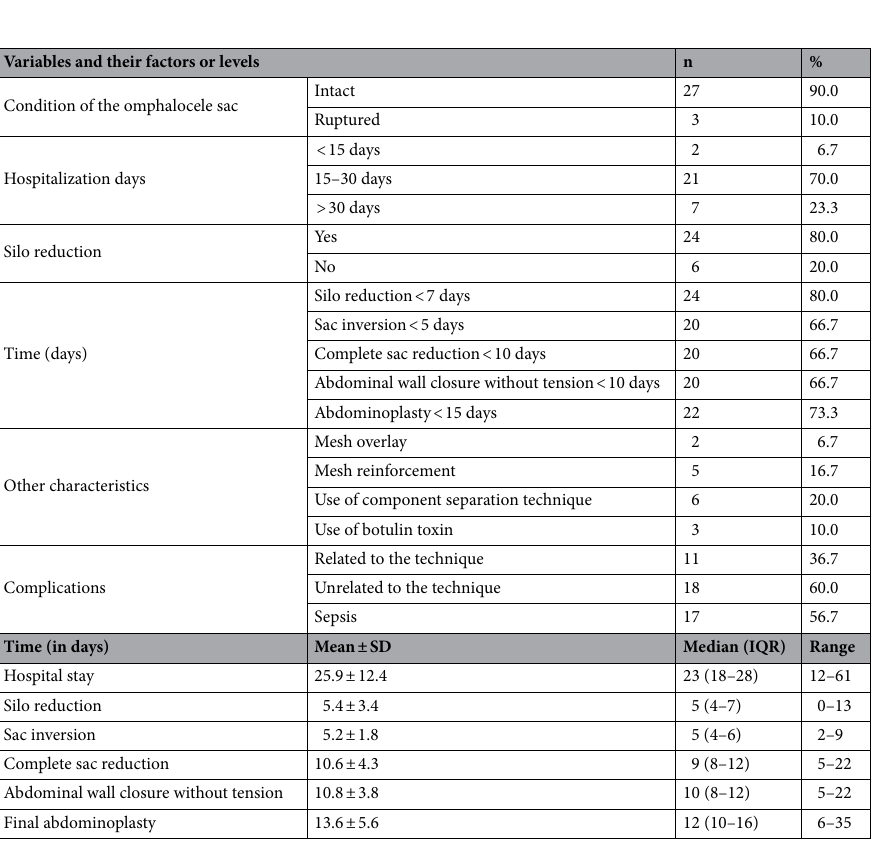
Table 2. Clinical and surgical characteristics of the study population. SD standard deviation, IQR interquartile range.